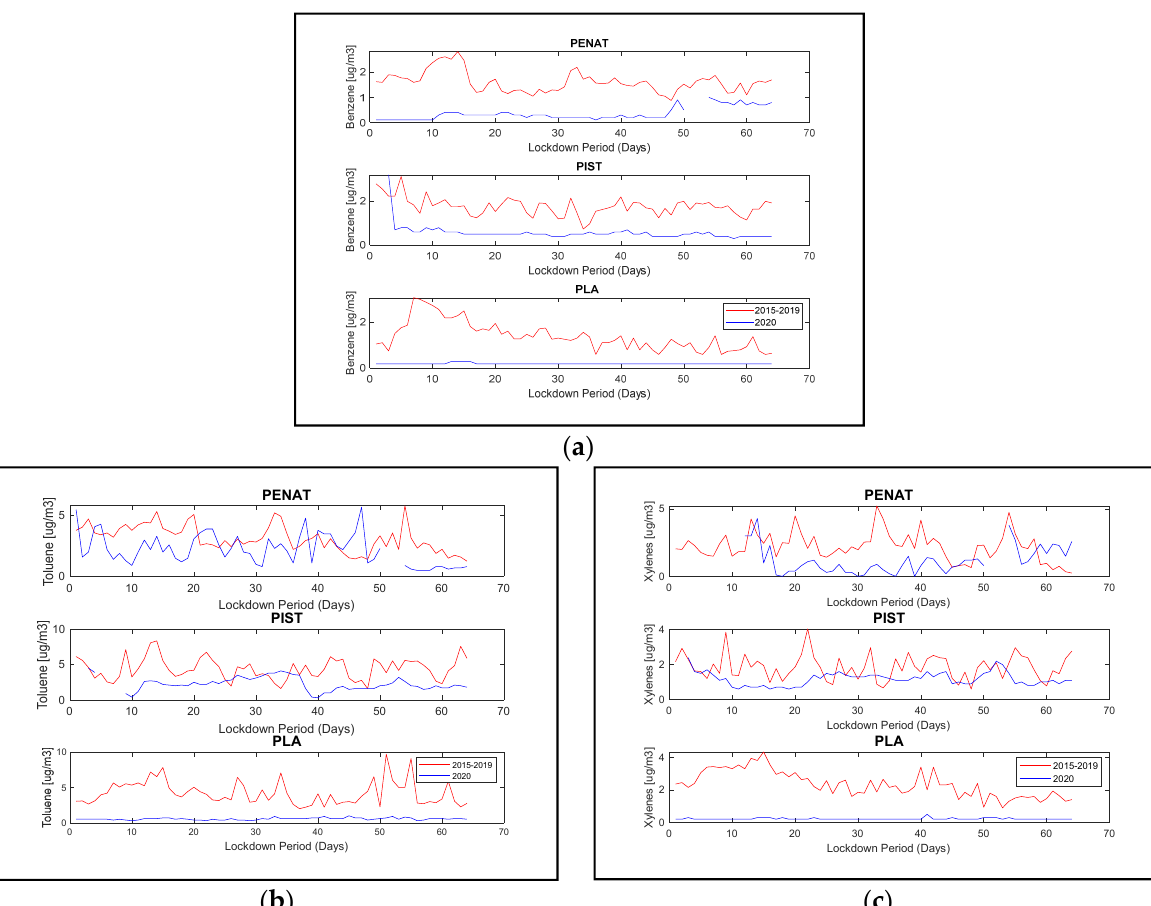
Figure 9. ( a ) Benzene ( b ) toluene and ( c ) xylene daily evolution at different stations during lockdown and reference period. Values expressed in µg·m − 3 .